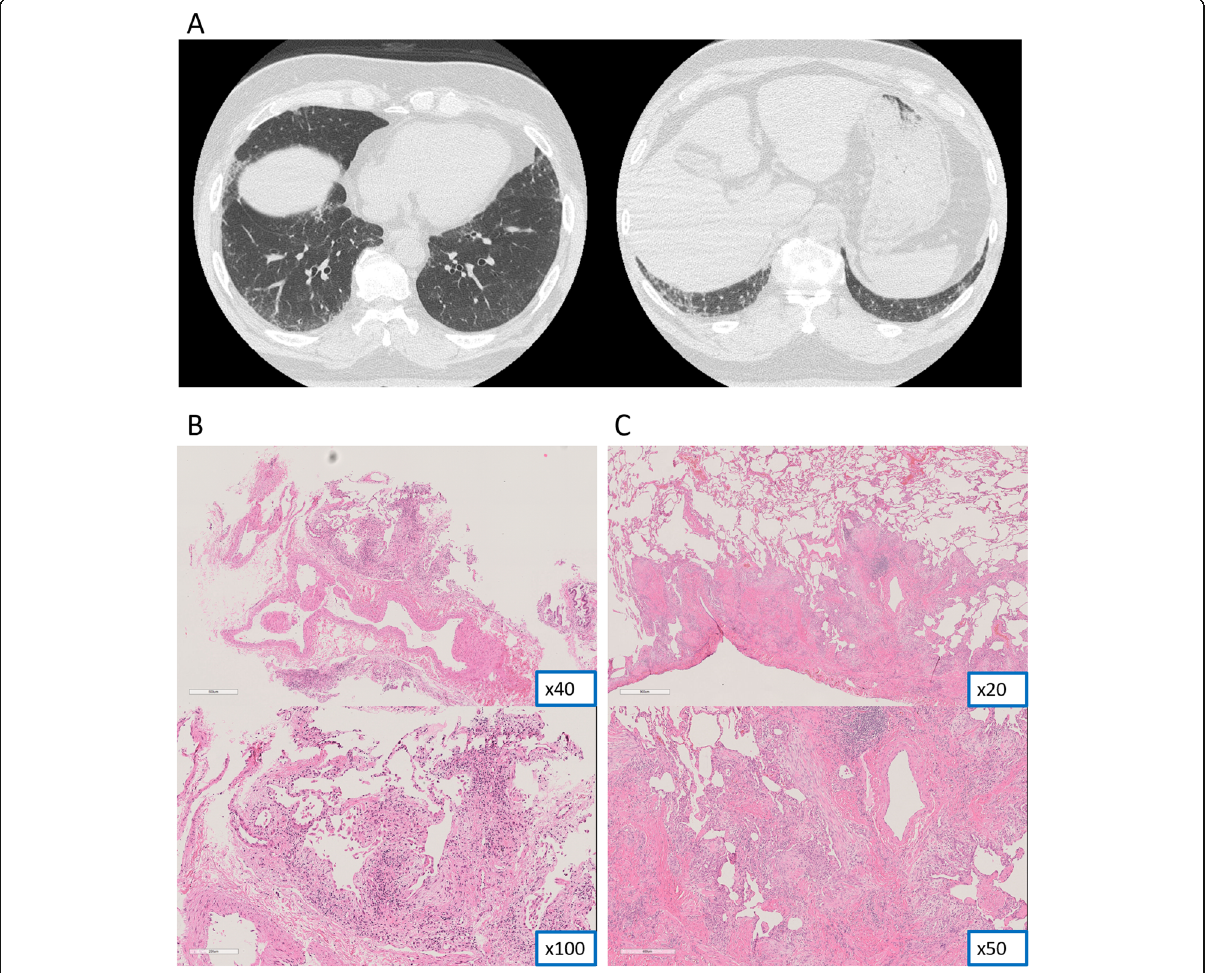
Fig. 2 a : HRCT shows linear and ground-glass opacities at the base of the lung. b : TBLC specimen indicates dense fibrosis with structural modifications in the edge of pulmonary lobule as well as fibroblast foci. c : SLB specimen reveals dense fibrosis and fibroblast foci with structural modifications spreading at the subpleural region and near the intralobular